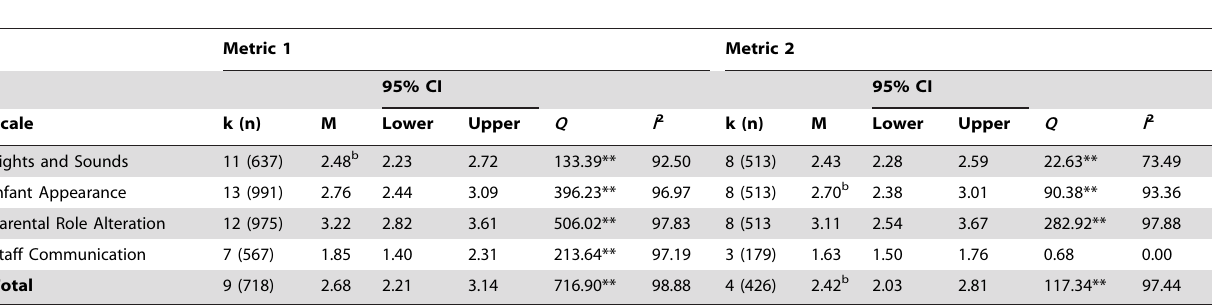
Table 5. Meta-Analytic Results of Parents’ Mean PSS:NICU Scores.